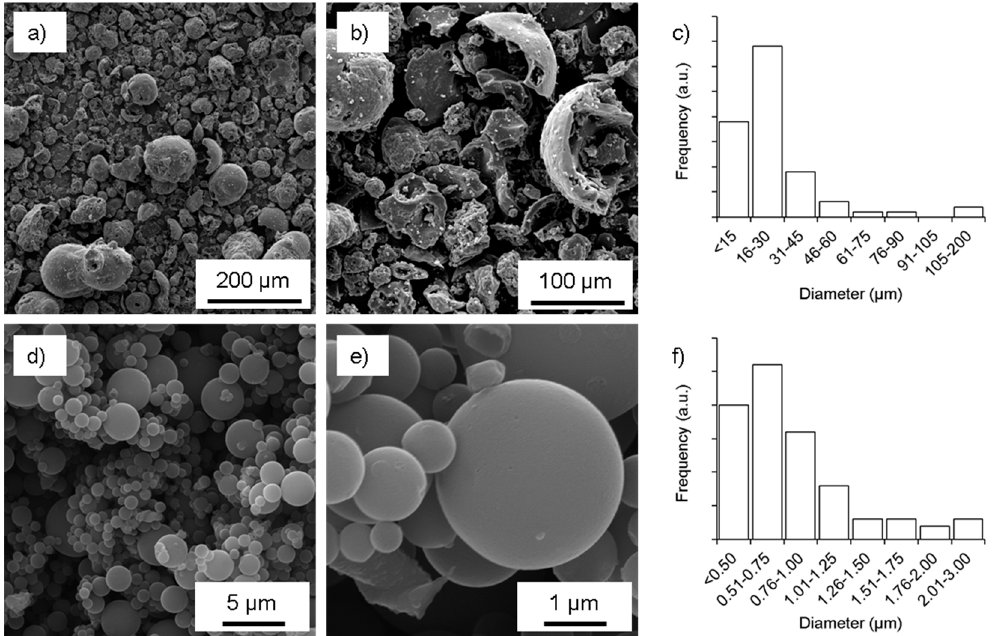
Figure 1. Scanning electron microscopy and diameter distribution (number frequency) of carbon particles derived from Indulin AT ( a – c ) and sub-micron lignin particles ( d – f ).